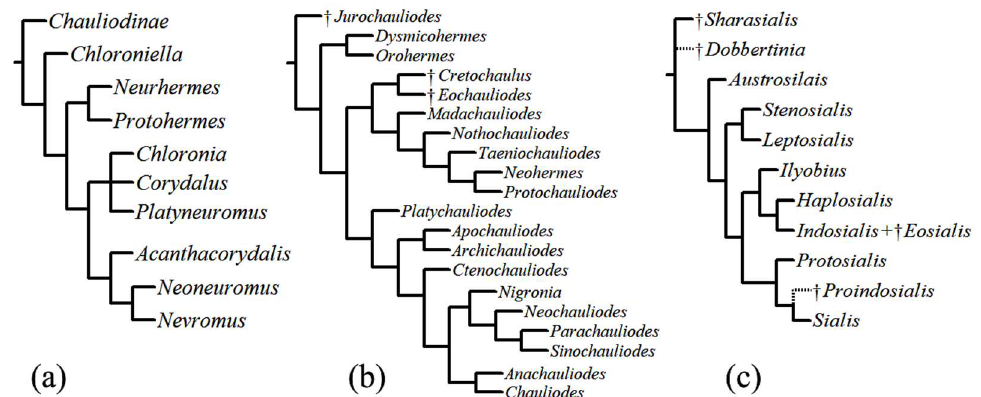
Figure 3. Phylogenetic trees. ( a ) phylogeny of Corydalinae proposed by Contreras-Ramos [32], ( b ) phylogeny of Chauliodinae proposed by Liu et al. [9], ( c ) phylogeny of Sialidae by Liu et al. [36] (putative positions indicated by dotted lines).